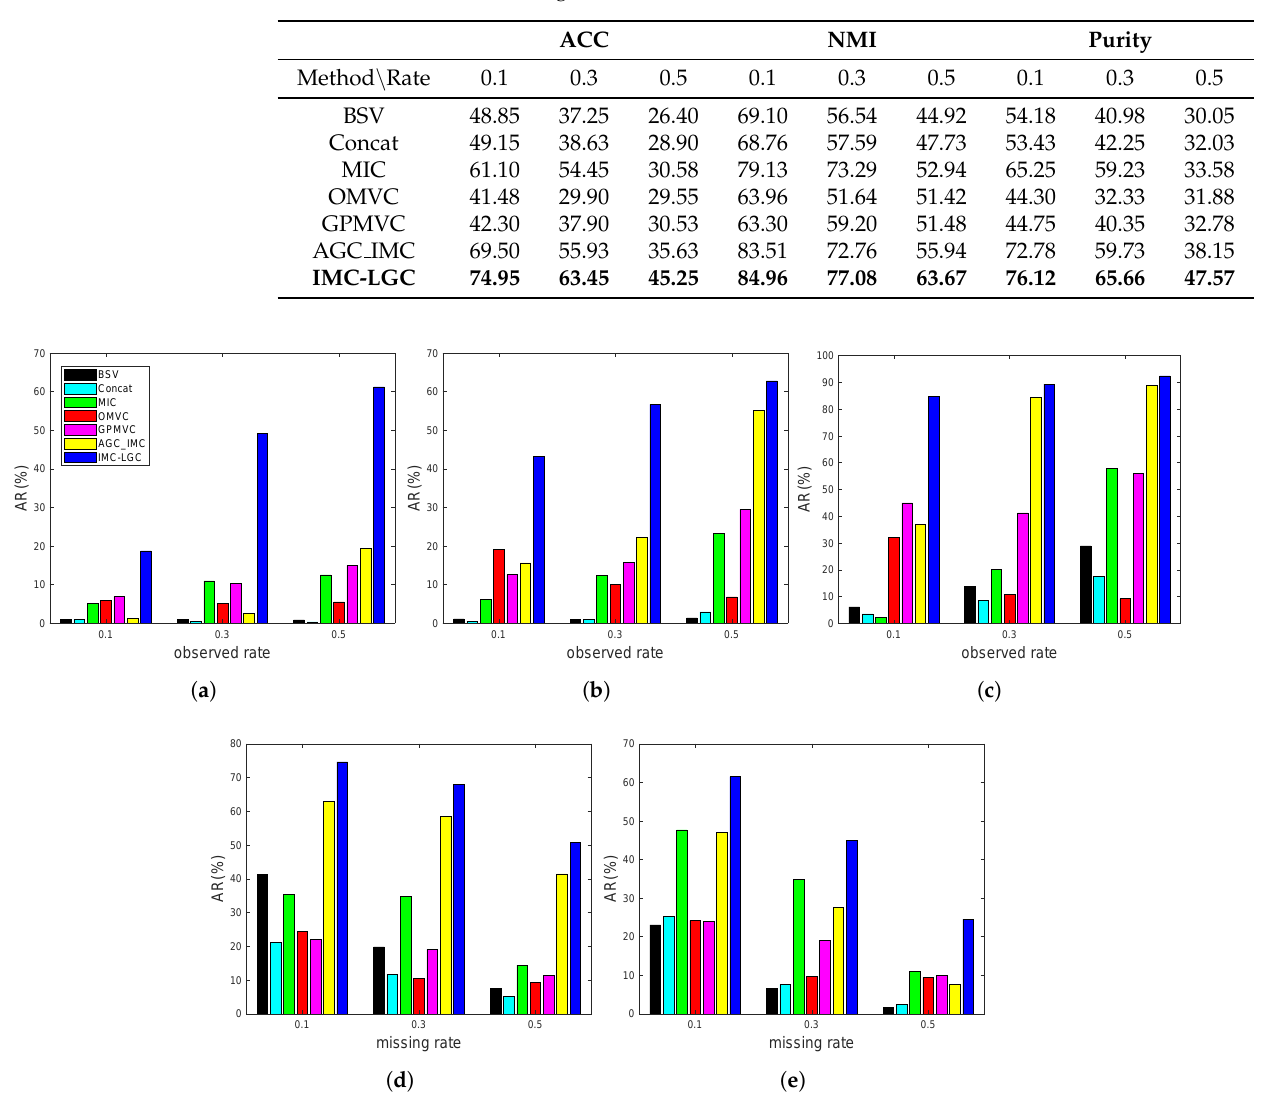
Table 5. Average values of ACC (%), NMI (%), and purity (%) of different methods on the ORL dataset with different missing view rates. Bold numbers denote the best results.